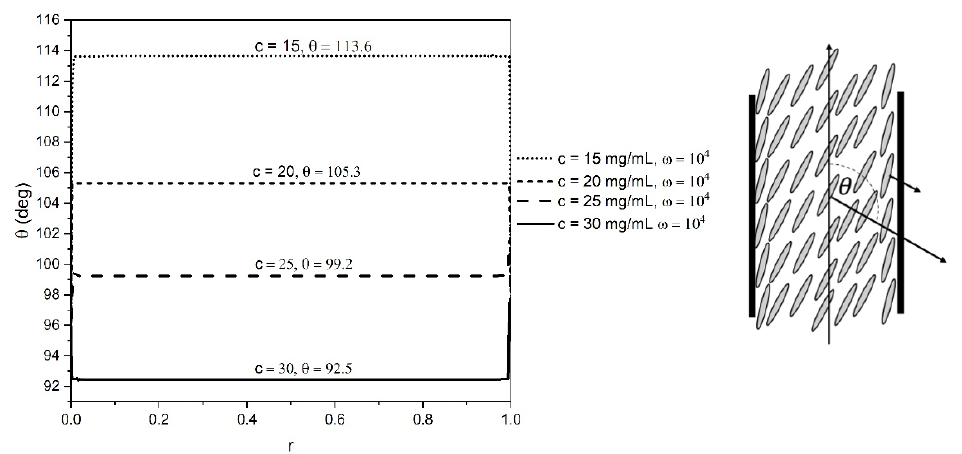
Figure 6. Orientation profiles for 15, 20, 25, and 30 mg/mL GO dispersions across the dimensionless gap at different dimensionless shear rates using the EL theory. Table 3. Comparison of theoretical and numerically obtained values for orientation angles at align- ment.